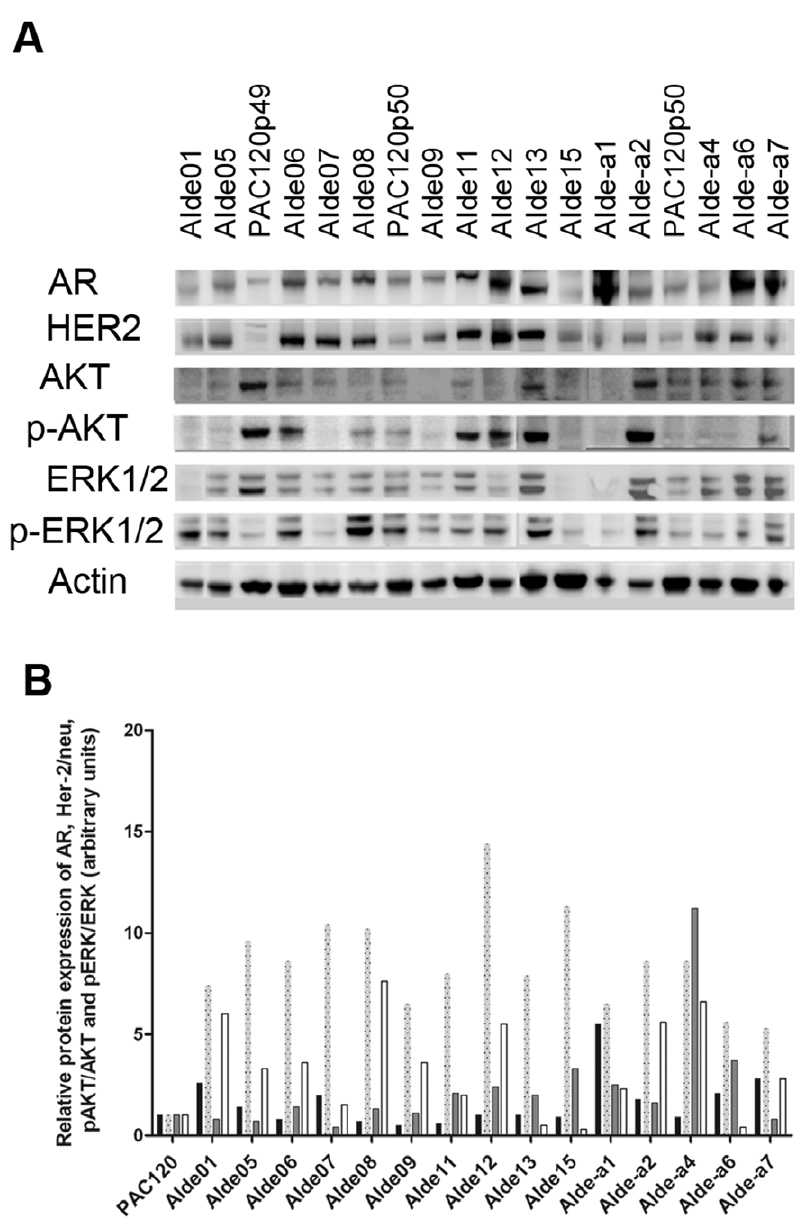
Figure 4. Protein expression of the androgen receptor (AR), human epidermal growth factor receptor 2 (Her-2/neu) and ratios of pAKT/AKT and pERK/ERK detected using A ) Western blotting analysis in androgen-independent (AI) variants. Actin was used as a control for loading protein. B ) Histograms representing the quantification of AR, Her-2/neu and ratios of pAKT/AKT and pERK/ERK normalized to actin and mean of PAC120 coming from various passages (expressed arbitrary units). AR (black bars) was expressed in PAC120 and all AI variants and Her-2/neu (dotted grey bars) was overexpressed in all AI variants. Either p-AKT/AKT (grey bars with full line) or pERK/ERK (white bars) were activated in AI variants. Abbreviations used to identify variants are explained in the legend of Figure